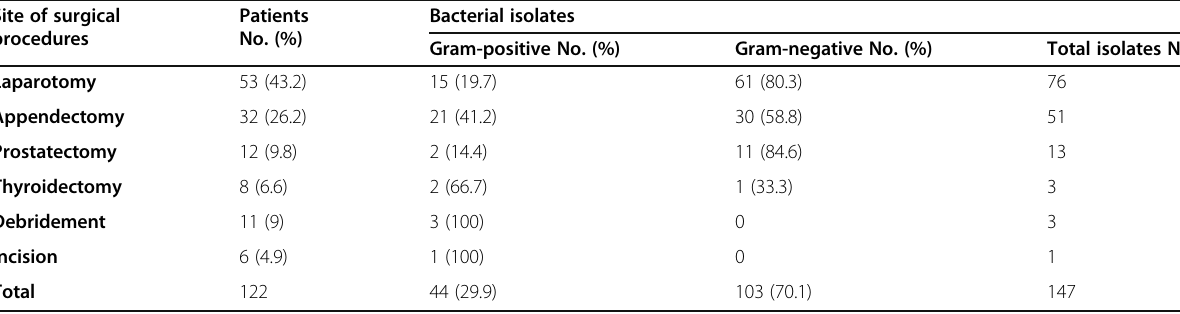
Table 3 Various surgical procedures and corresponding bacterial isolates from patients Site of surgical procedures